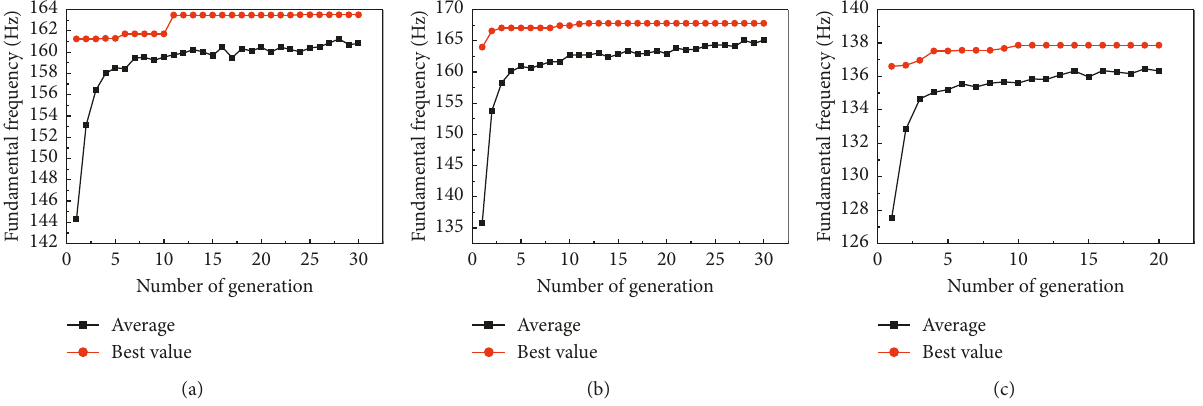
Figure 9: Optimal shapes of Shell 1 obtained by the first phase optimization with different initial lay-ups. (a) Initial lay-up [45 ° / − 45 ° (b) Initial lay-up [0 ° /90 ° 2 /0 ° ] 2s . (c) Initial lay-up [0 ° ] 8s .